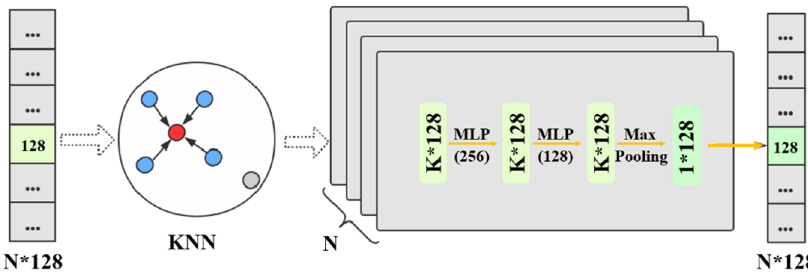
Figure 5. Illustration of the structure of the local feature extraction module.